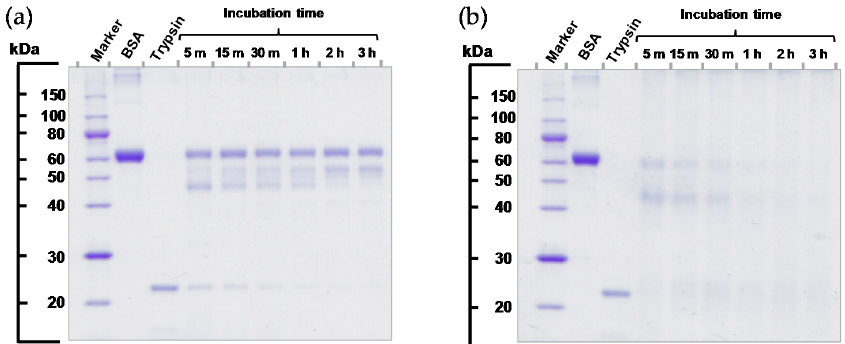
Figure 4. Sodium dodecyl sulfate ‐ polyacrylamide gel electrophoresis (SDS ‐ PAGE) analysis of bovine serum albumin digested with ( a ) unmodified trypsin at 37 °C and ( b ) vinylmethylether ‐ maleic acid copolymer (VEMAC) ‐ Tryp at 55 °C. BSA: bovine serum albumin.